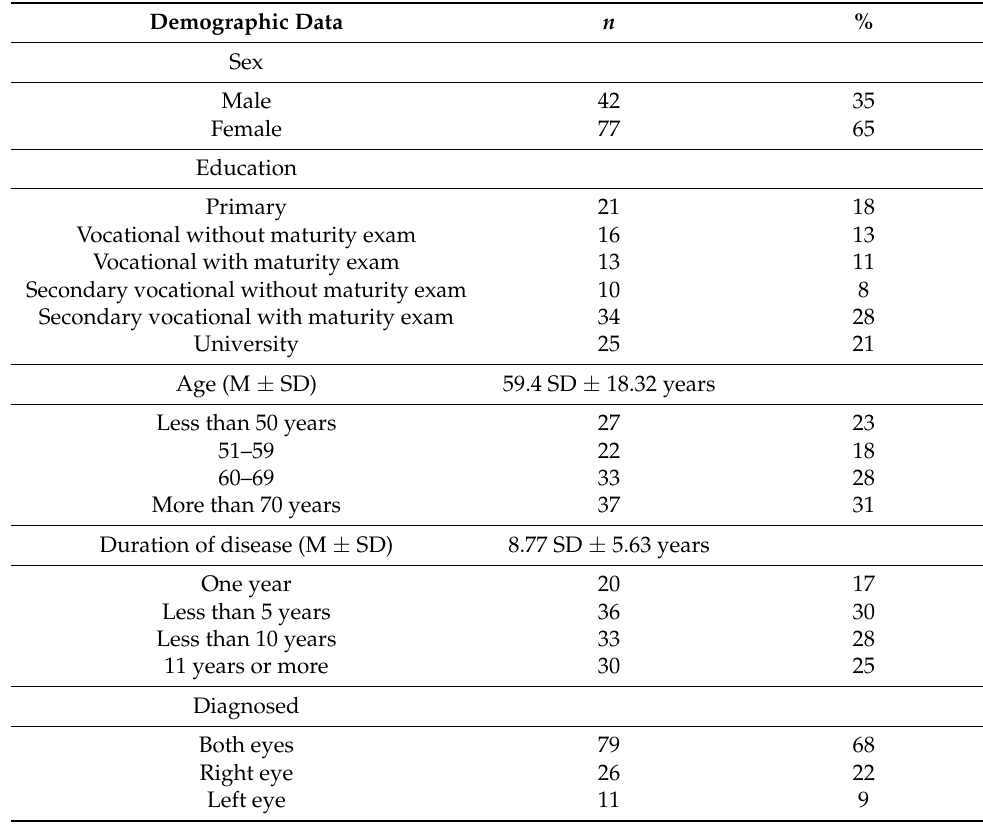
Table 1. Sociodemographic data.